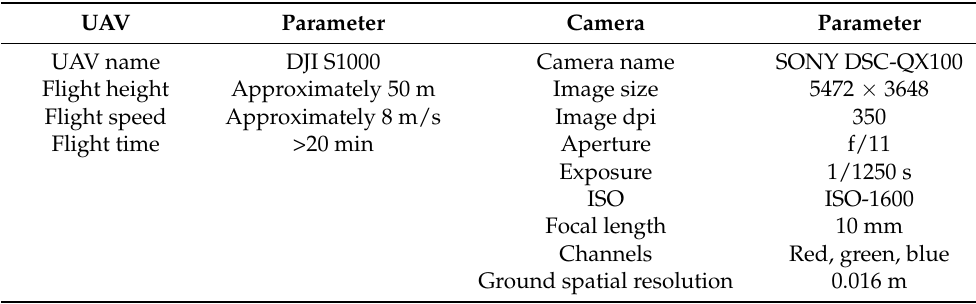
Table 1. Parameters of the UAV and digital camera used in this study.